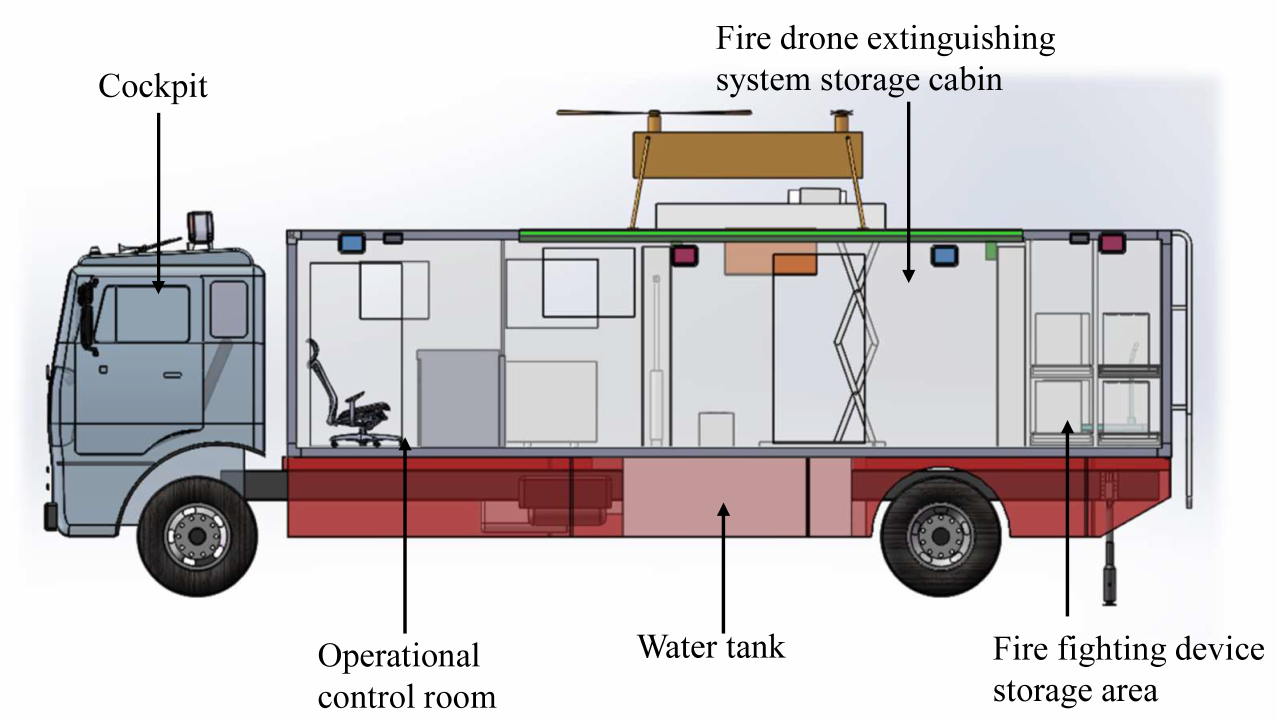
Figure 3. Special command transport